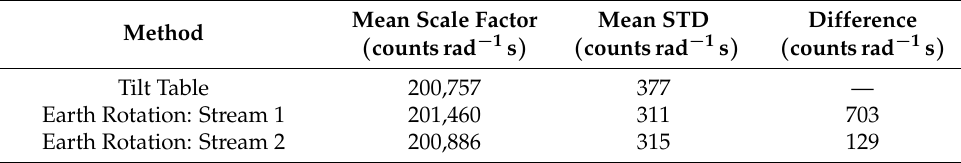
Table 3. The mean scale factors of all components combined, and the standard deviations of the scale factors for sensor number 0083 computed from tilt table input and from comparison with the earth’s rotation rate from two quiet streams of data: Stream 1: 27 November to 29 November and Stream 2: 29 November to 2 December, with the difference between these two methods.